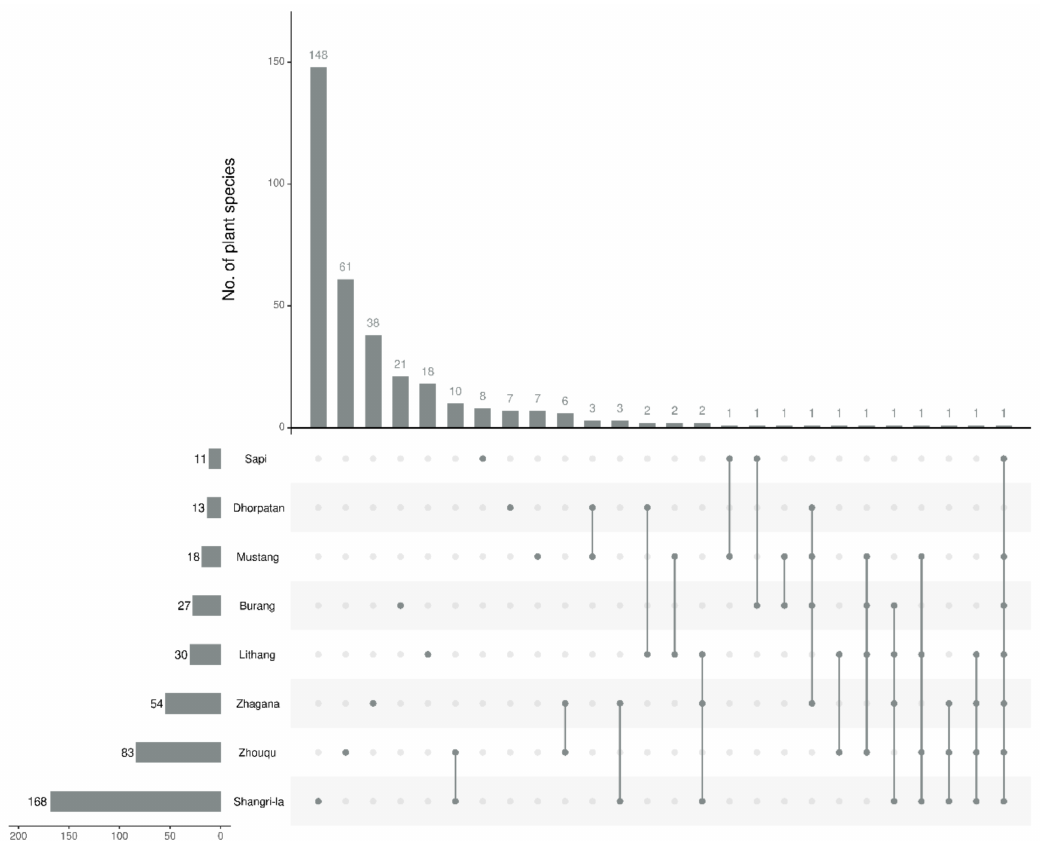
Figure 8. Comparison of plants used in eight regions. The bar chart on the left shows the original number of wild edible plants used by Tibetans in different regions; dot refers to the corresponding region name on the left in the intersection below; the connection between dots indicates that Tibetans in different regions jointly use some wild edible plants; upper histogram represents the number of plant species at this